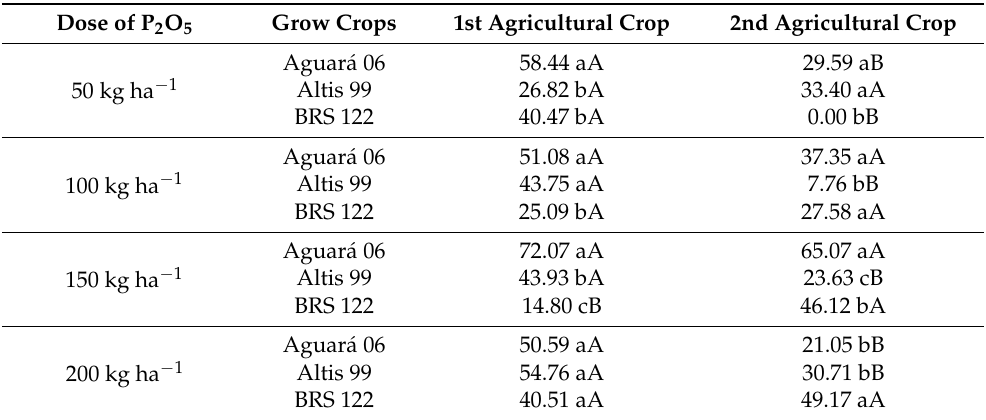
Table 3. Average values for agrophysiological efficiency as a function of sunflower cultivars within phosphorus doses in agricultural